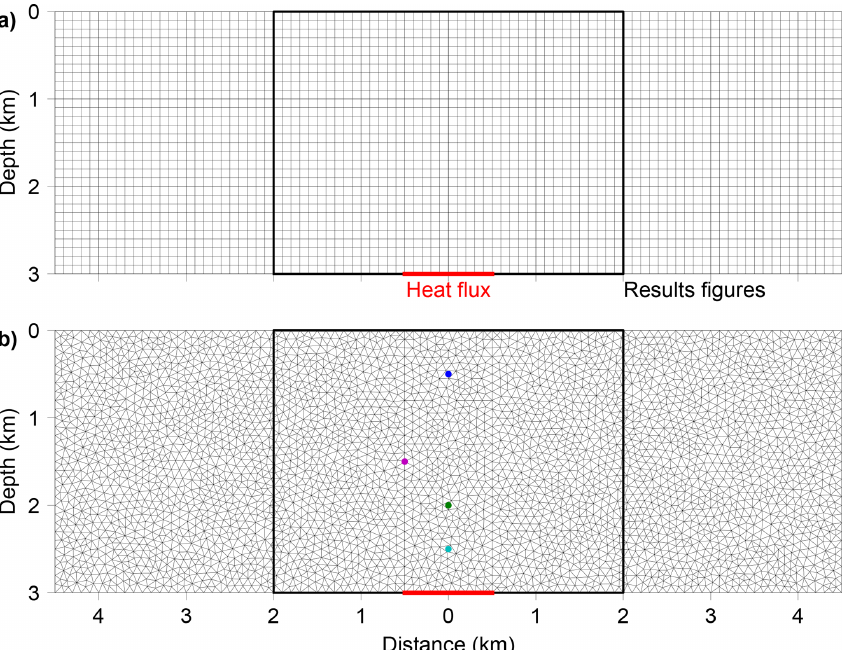
Figure 6. Mesh and model configuration of the two-dimensional examples. (a) The grid for HYDROTHERM has to be set to a uniform regular mesh with resolution of 100m and a total number of 2700 elements. (b) HydrothermalFoam uses an unstructured mesh with 7074 triangular elements and an edge length in the range of 60–142m. Red lines on the bottom boundaries denotes heat flux boundary condition for temperature.